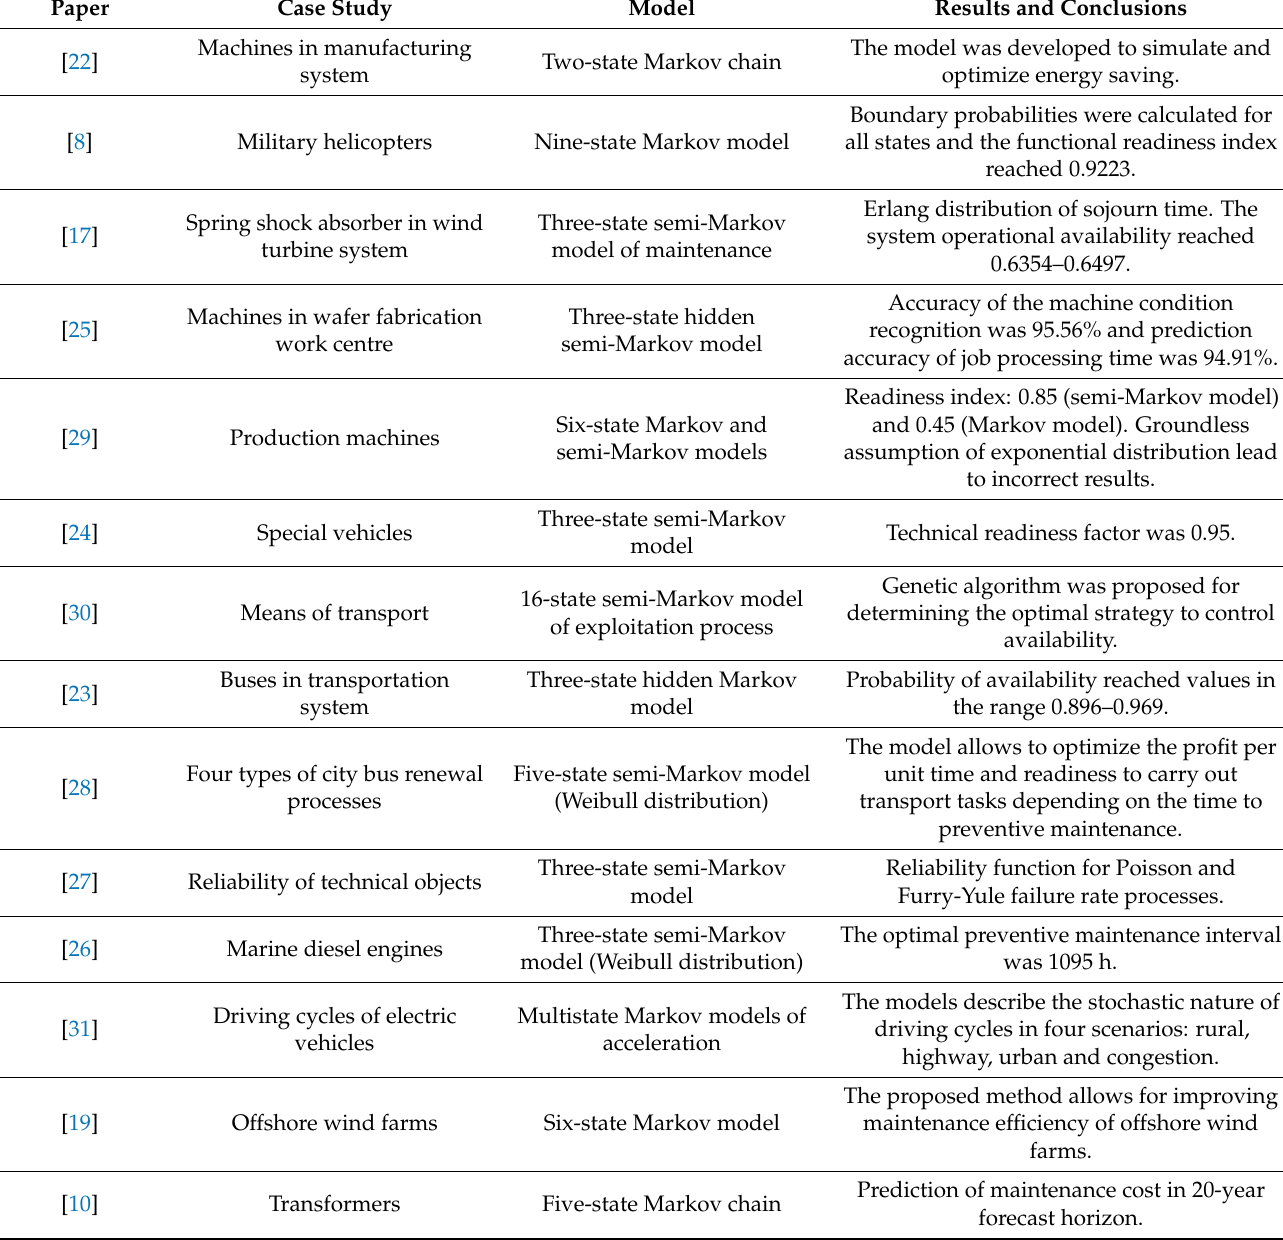
Table 1. Literature review of Markov and semi-Markov modeling in